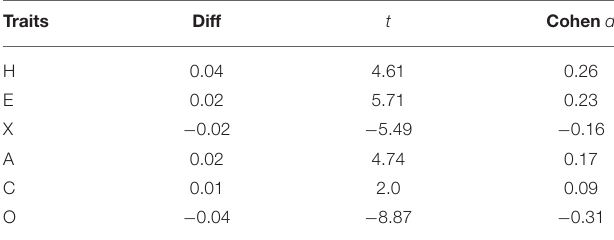
TABLE 5 | Mean differences between predicted female ( N = 5,673) and male ( N = 5,760) trait scores ( p < 0.001). Traits Diff t Cohen